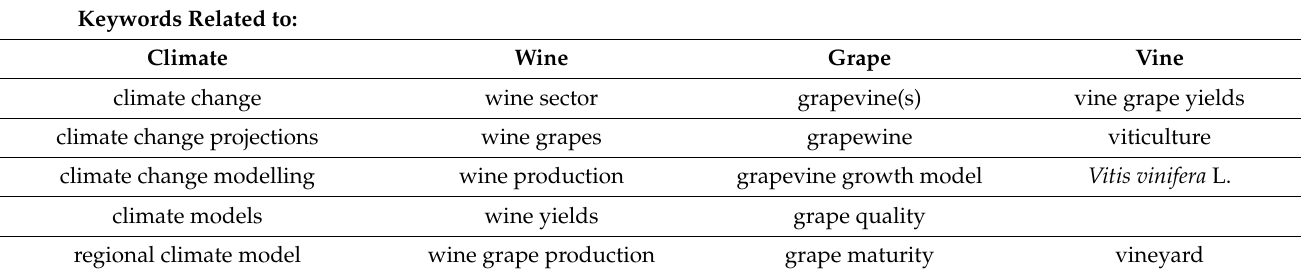
Table 1. Keywords applied for conducting multiple search